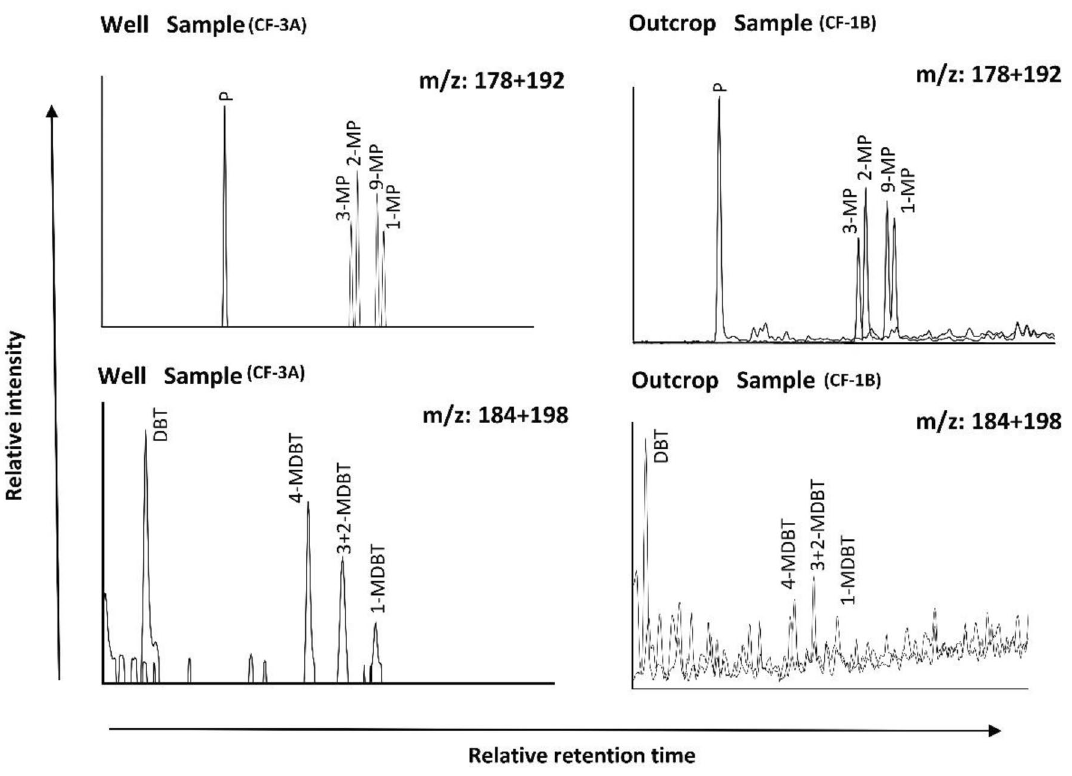
Fig. 14 Aromatic hydrocarbon composition; top 2 are the representative chromatograms that show distribution of P and MP, and bottom 2 are the representative chromatograms that show relative abundance of DBT and